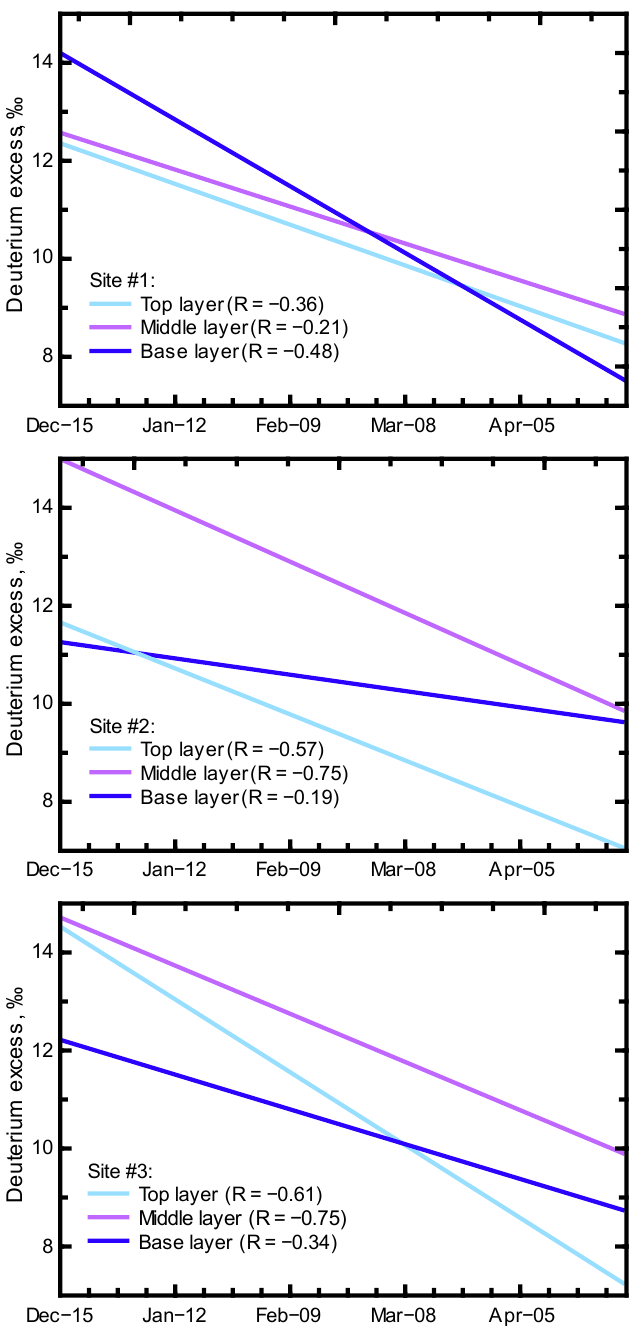
Figure 8. Linear regression trendlines of deuterium excess with time at the three snowpack sites.